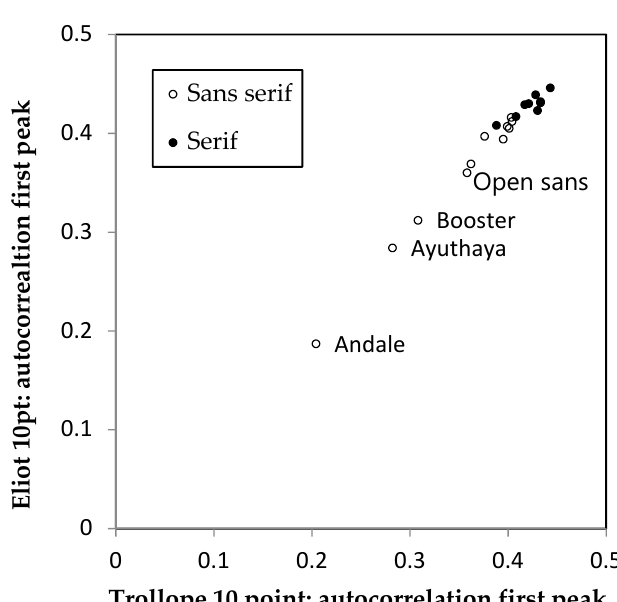
Figure 2. The first peak in the horizontal autocorrelation of two pages of text, one containing text from Eliot and the other from Trollope. Both samples were printed in one of 20 fonts. The fonts with low first peak in the autocorrelation have been identified.